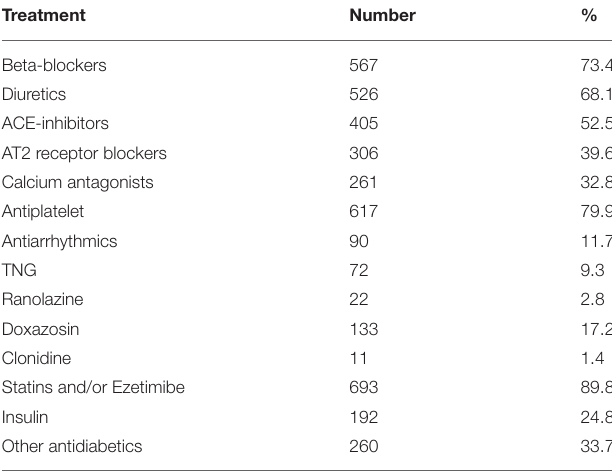
TABLE 2 | Pharmacological